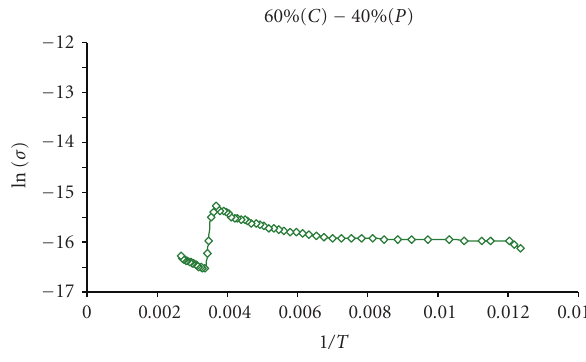
Figure 5: The comparison of I-V characteristic for samples no.2 and no.3 at a higher temperature.